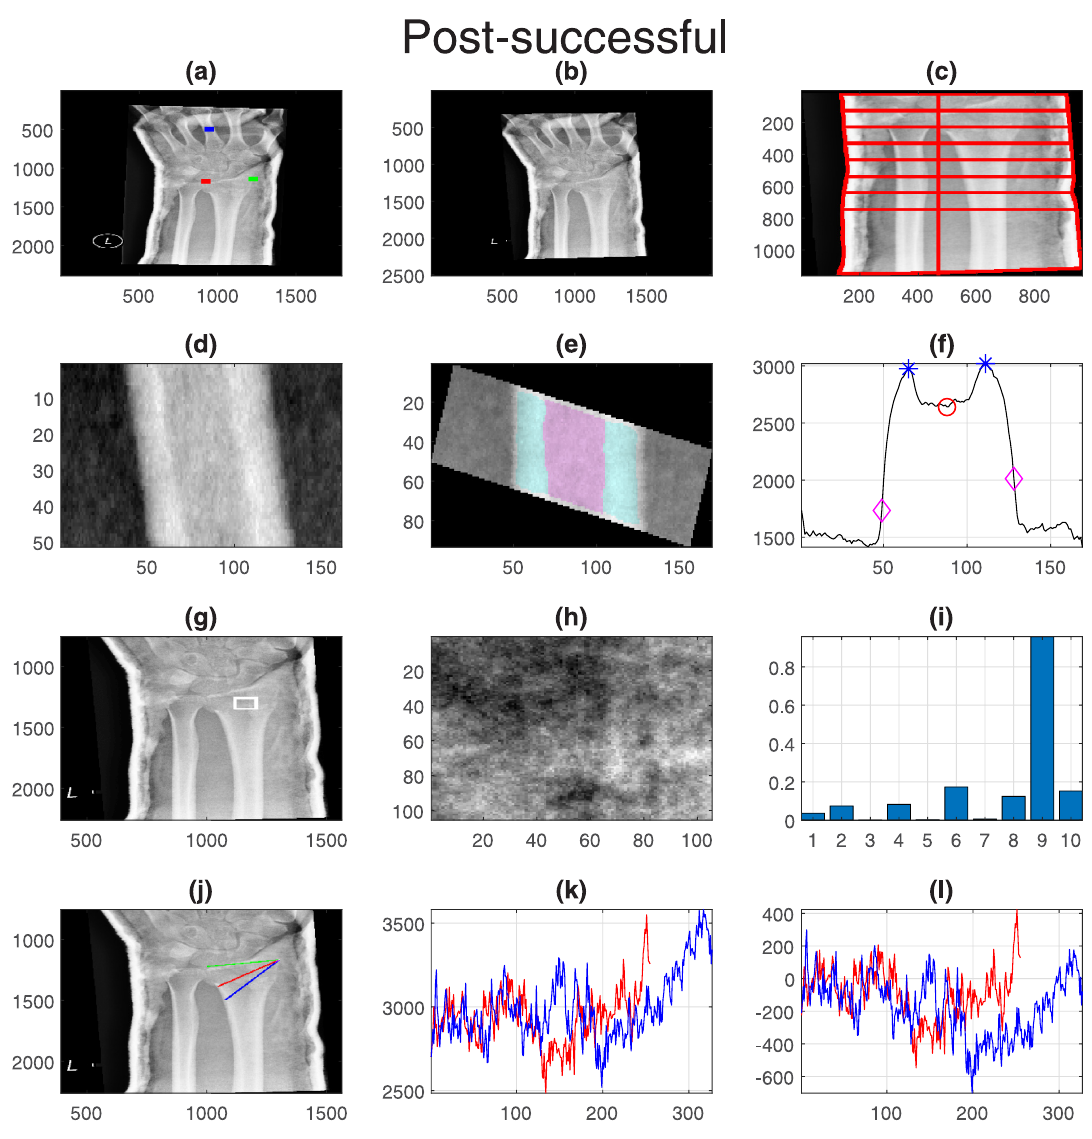
Fig 13. Post-successful: One representative case with all its measurements. Refer to Fig 11 for the